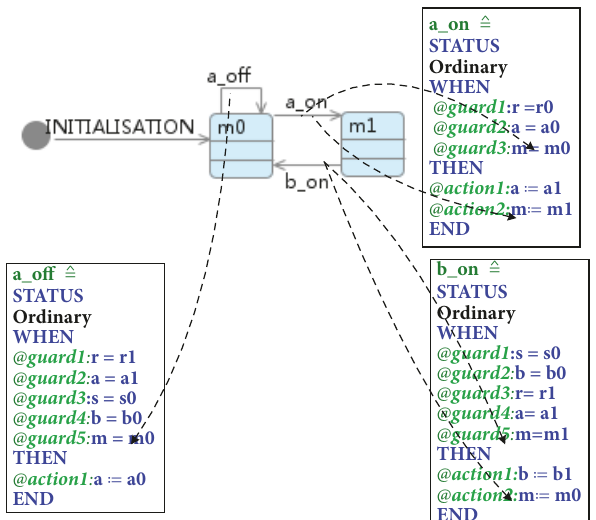
Figure 13: The iUML-B state machine 𝑚 and the Event-B codes it generated.